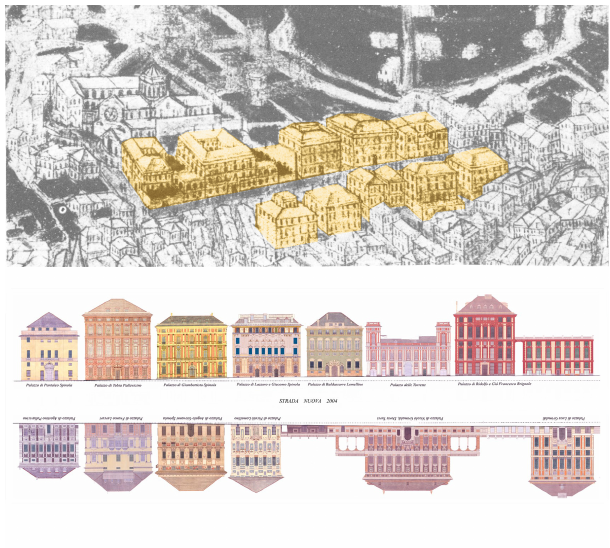
Figure 5: A synthesis image of Strada Nuova compared to an historical